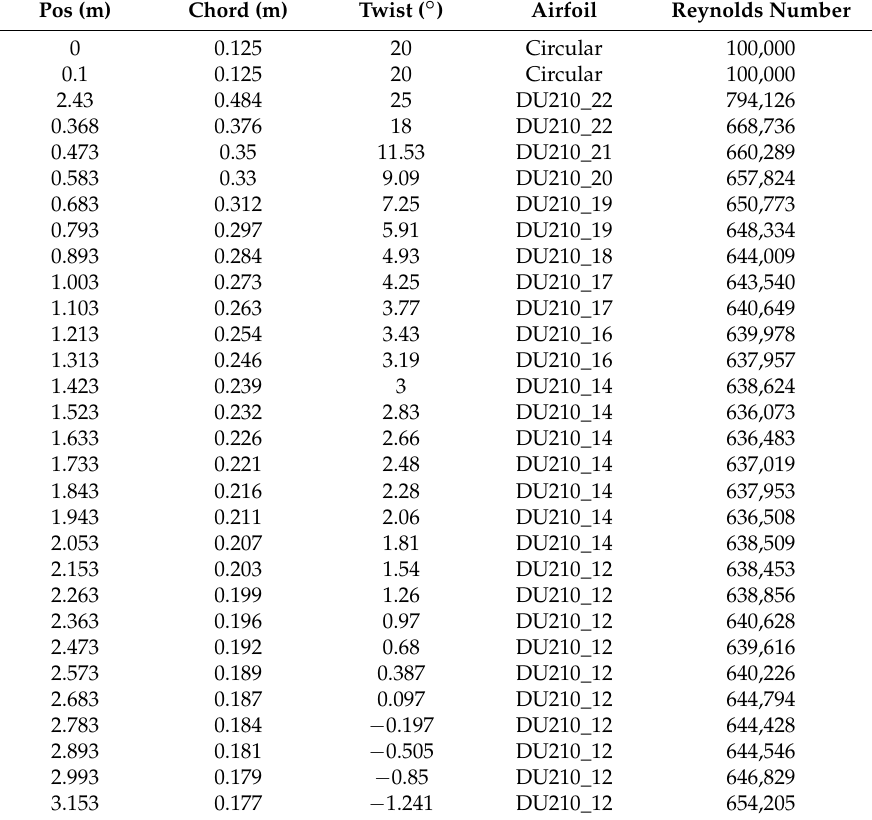
Table A2. Stall wind turbine blade